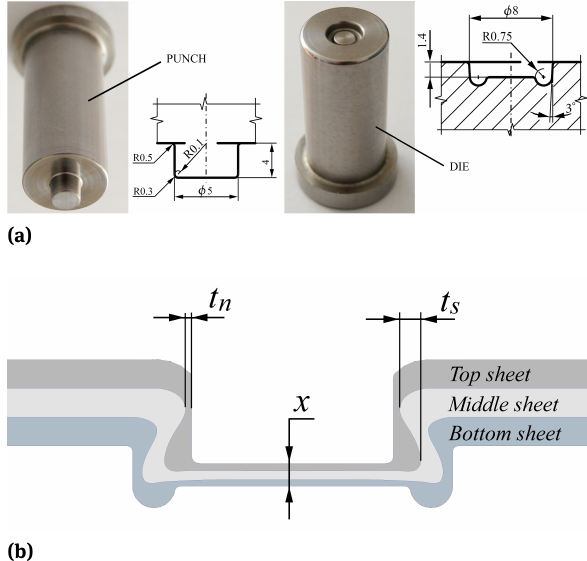
Figure 2: Clinching: (a) dimensions of clinching tool and (b) parame- ters of clinched